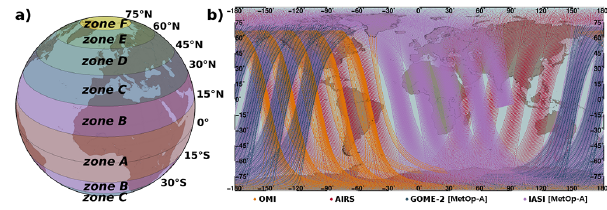
Fig. 6. (a) Geographical zones used in Table 2; (b) 8h of monitoring from SACS instruments (example used: 27 October 2012, with four